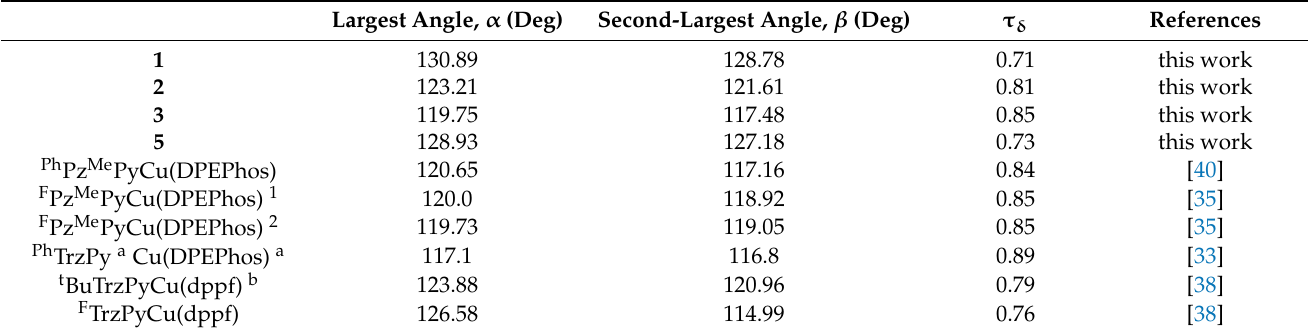
Table 1. Selected structural parameters and τ δ values for 1 – 3 , 5 and reported analogs. Largest Angle, α (Deg) Second-Largest Angle, β